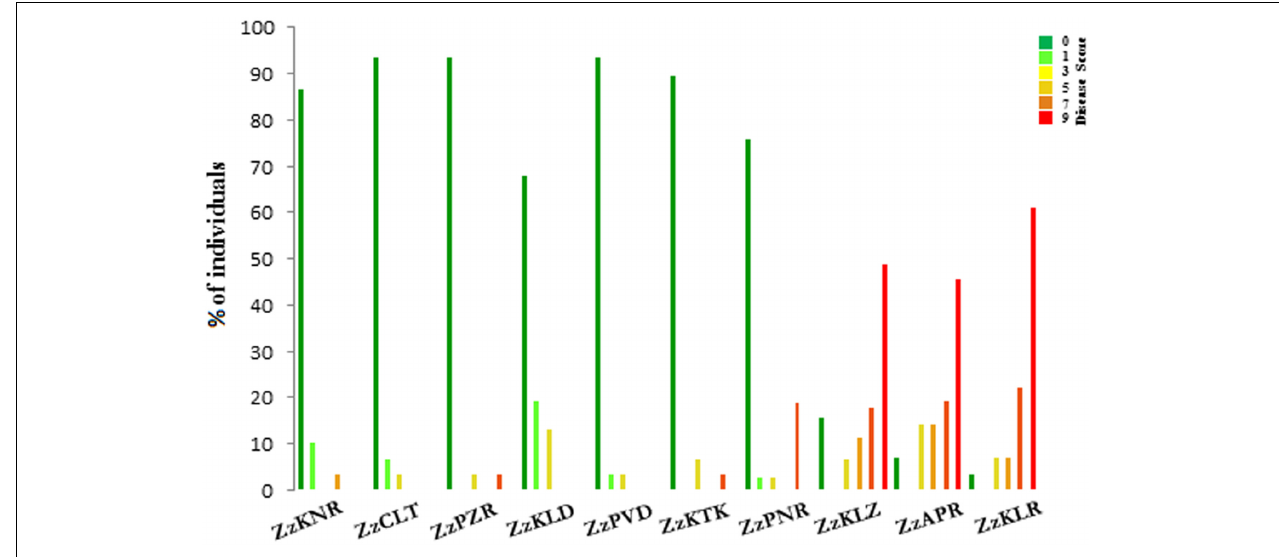
FIGURE 2 | Histogram of the percentage of individuals belonging to different disease score classes in 10 populations of Zingiber zerumbet.